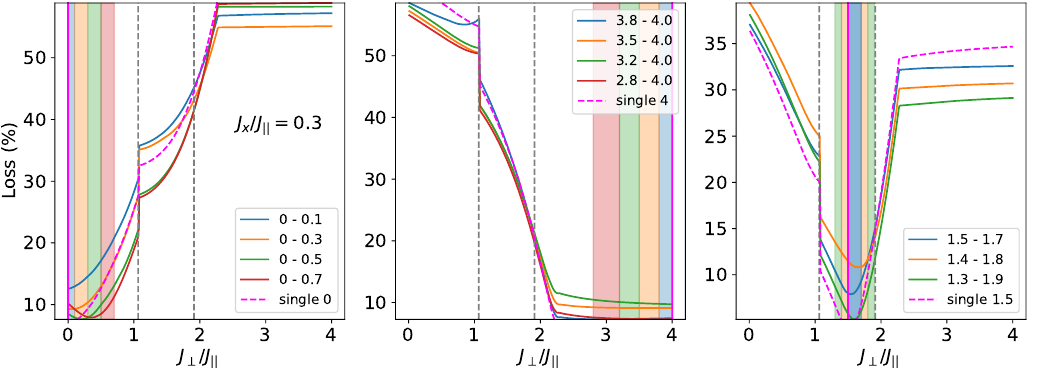
Figure 3: Varying the training region to show that the outcome of the algorithm is not sensitive to the number of training examples N region. The number of epochs N i.e. the neural network sees the same amount of examples throughout all training iterations. We see that we can even map out the regions with just one single training example (dotted magenta